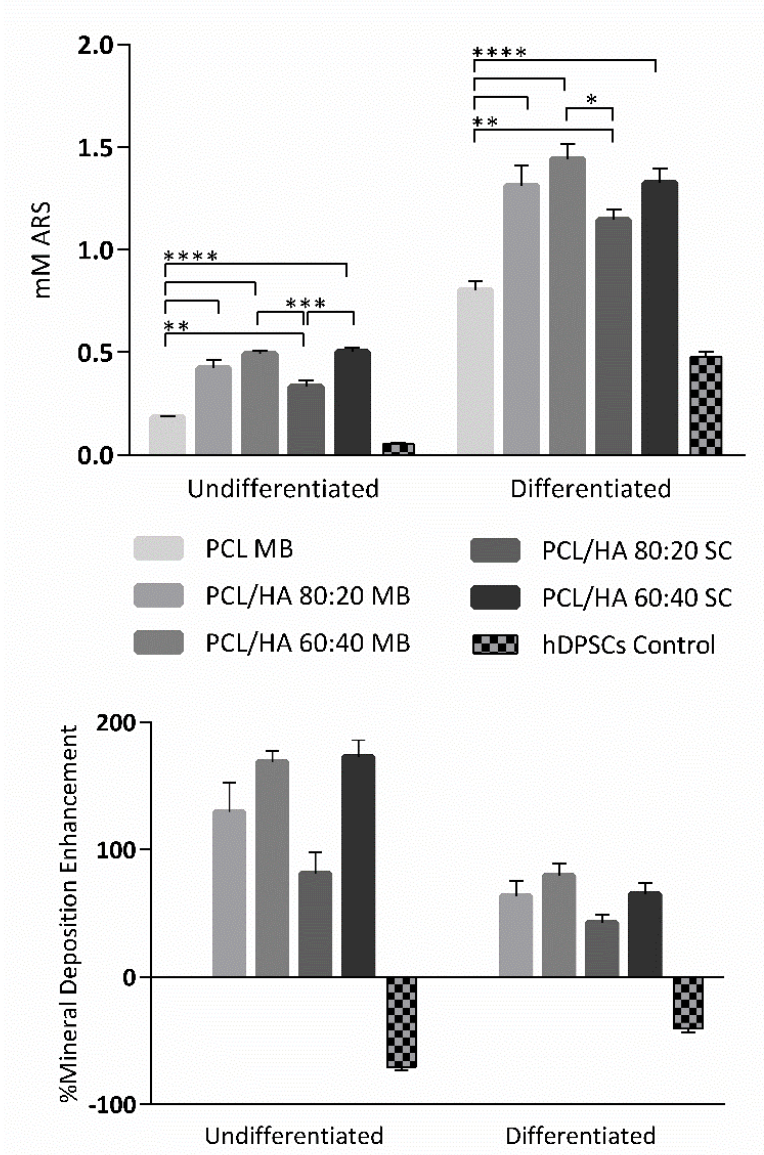
Figure 9. ARS semi-quantification in mM between groups. The results are presented in mean ± SE. Differences were considered statistically significant at p ≤ 0.05. The results’ significance is presented through the symbol (*), according to the p value, with one, two, three or four symbols, corresponding to 0.01 < p ≤ 0.05; 0.001 < p 0.01; 0.0001 < p ≤ 0.001 and p ≤ 0.0001, respectively. Table 6. ARS semi-quantification in mM between groups. The results are presented in mean ± SE. “Undif.” Stands for “Undiferentiated” and “Dif.” Stands for “Differentiated”.